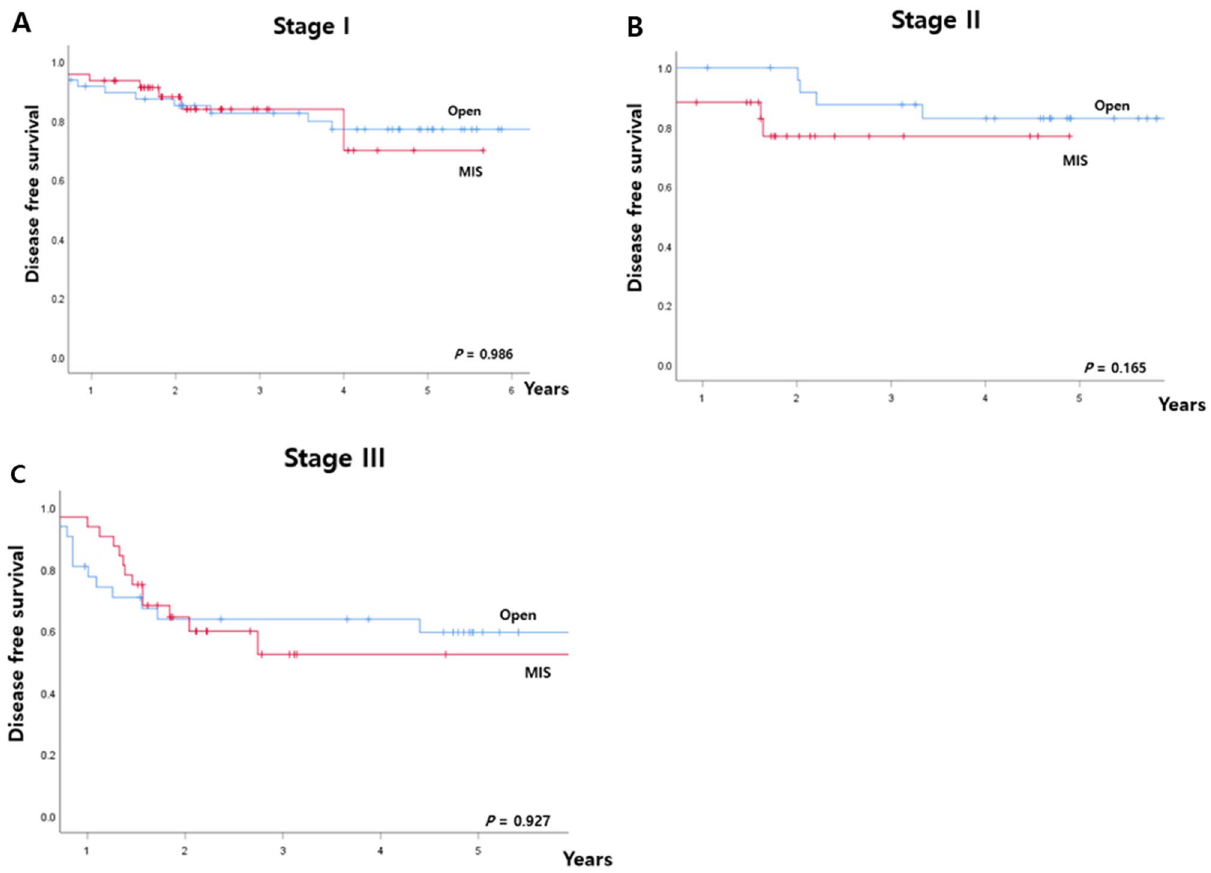
Figure 2. Five-year disease-free survival rates according to operative approach in matched patients ( A ) stage I, ( B ) stage II, ( C ) stage III